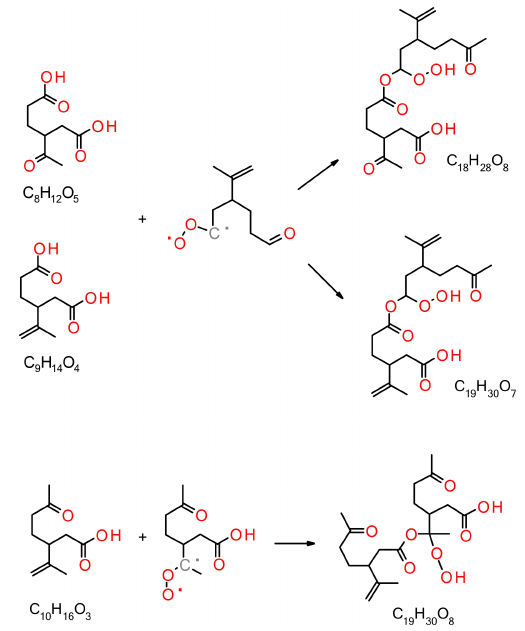
Figure 7. Proposed formation of observed dimers (C 18 H 28 O 8 , C 19 H 20 O 7 and C 19 H 30 O 8 ) from monomer–Criegee